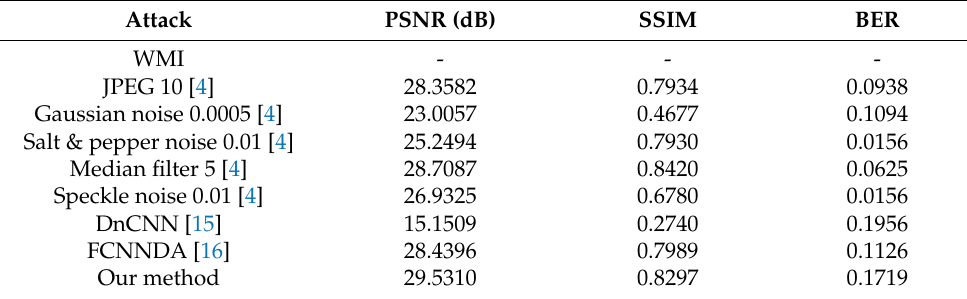
Table 3. Comparison of evaluation indicators; watermark size of 8 × 8.